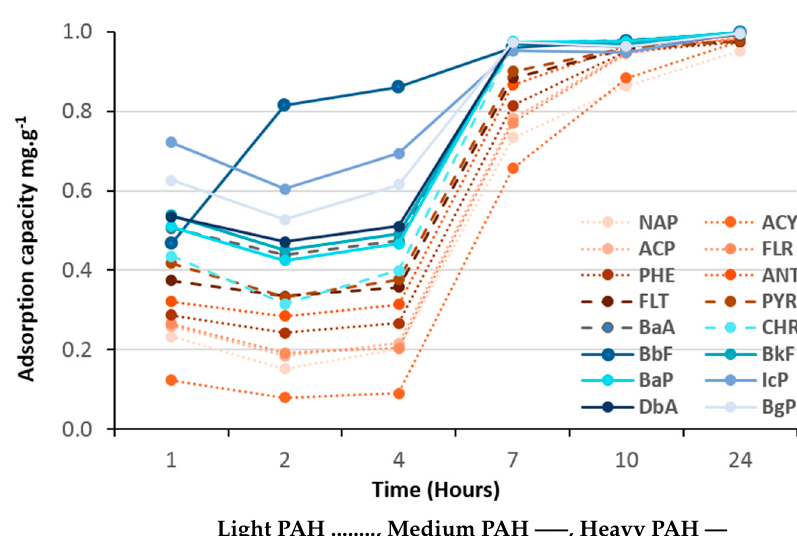
Figure 9. Adsorption kinetics of 16 PAHs on (TiO 2 ) 100 (PPA).